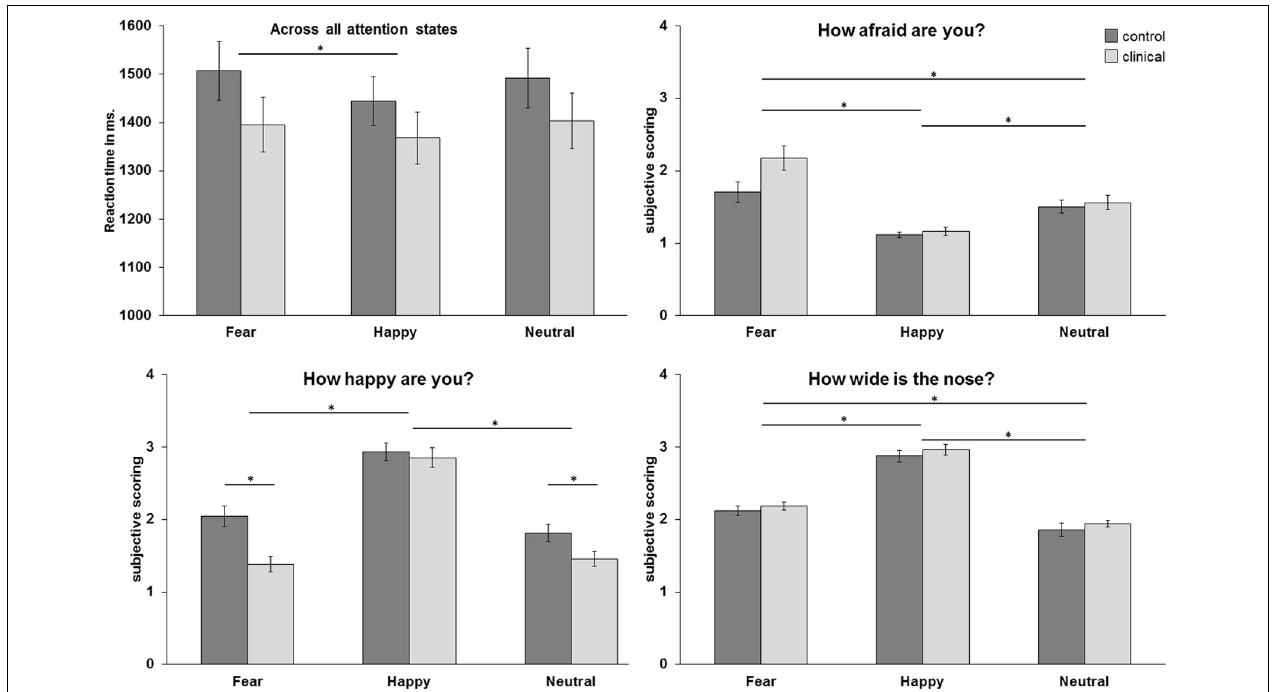
FIGURE 2 | Mean reaction times in milliseconds across all attention conditions and mean subjective scoring per attention condition. ∗ p < 0 .